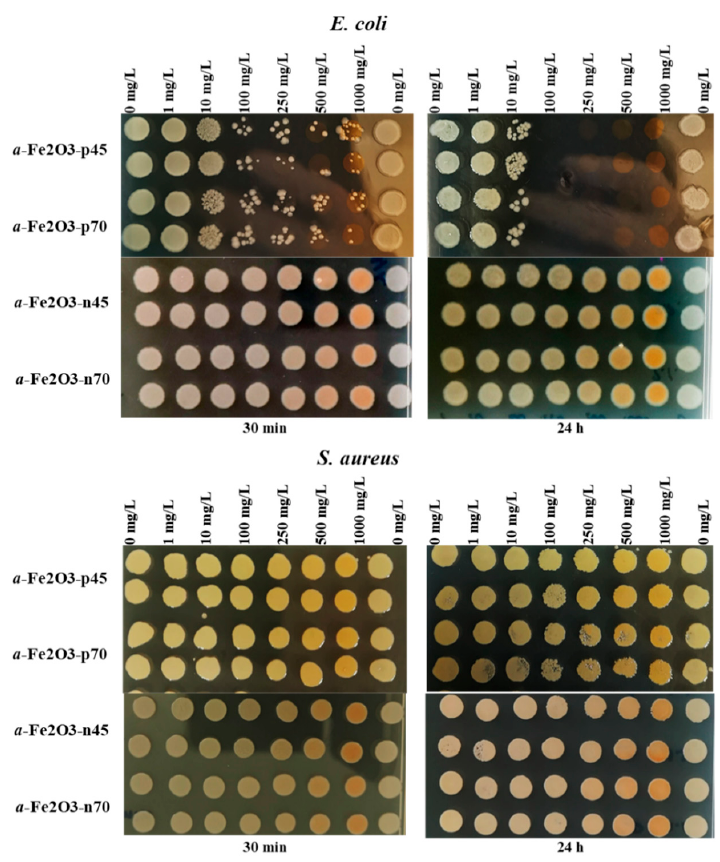
Figure 5. Viability of Escherichia coli (upper panels) and Staphylococcus aureus (lower panels) after exposure to α -Fe 2 O 3 NPs in DI water for 30 min and 24 h at room temperature. Viability was evaluated by the ability of exposed bacteria to yield colonies at the nutrient agar plate as indicated on the panels.